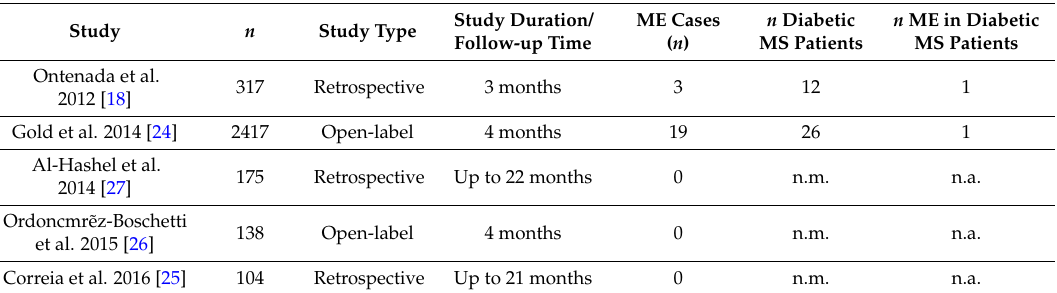
Table 3. Frequency of macular edema (ME) cases in real-world multiple sclerosis (MS) populations. n.m. = not mentioned; n.a. = not